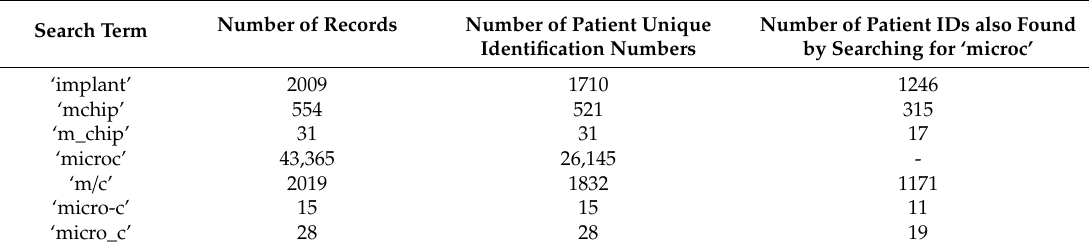
Table 2. The number of records (potential microchip implantation events) returned from a cohort of 1,631,322 VetCompass Australia electronic patient records associated with a veterinary consultation in the year 2017 and a 15 digit number recorded in the ‘microchip’ field.